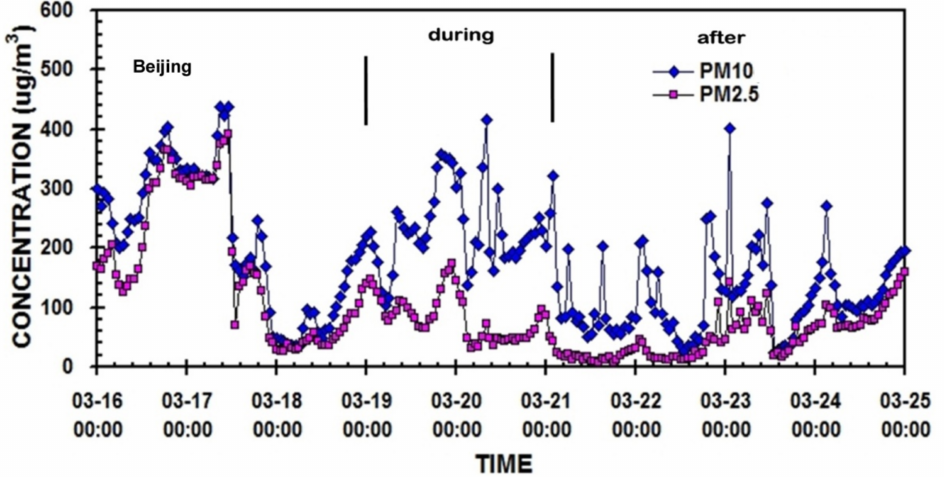
Figure 4. Hourly distribution of PM 10 , PM 2.5 and PM 1 concentrations from 16 March to 25 March, 2015 in Beijing city, China. As the transport of the dust of Beijing city to Gangneung city takes two days by 8 m/s northwesterly wind simulated by WRF-3.6.1 numerical model, and Choi and Zhang [22], two-day-earlier PM data (01:00 LST, 19 March to 00:00 LST, 21) correspond to PM data of Gangneung city for the dust period (01:00 LST, 21 March to 00:00 LST, 23) in Figure